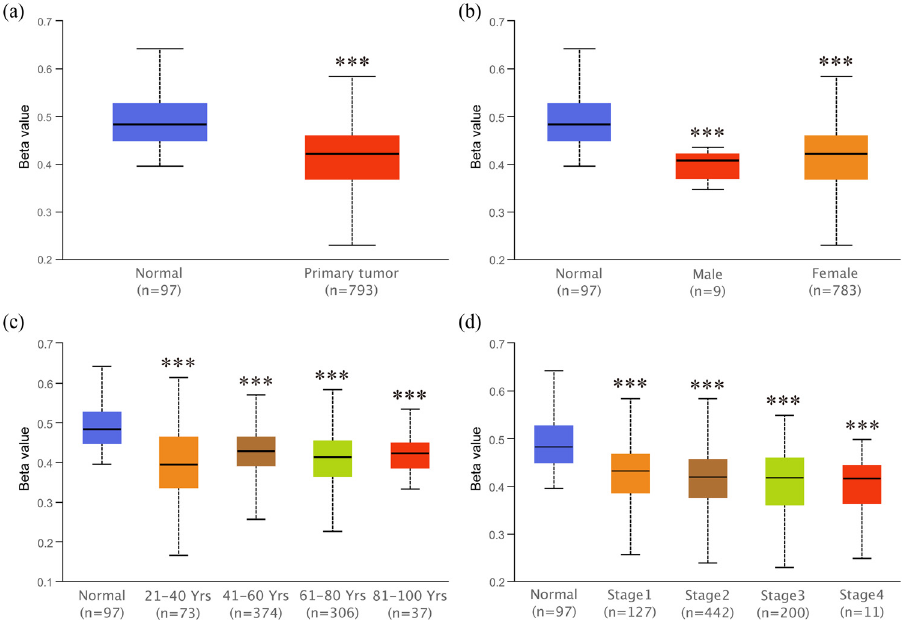
Figure 5: Analysis of ZG16B promoter methylation status in breast cancer patients with di ff erent clinical - pathologic features. Ualcan analysis showed the methylation level of ZG16B promoter in primary tumor of breast cancer ( a ) and in breast cancer patients with distinct gender ( b ) , age ( c ) , and cancer stages ( d ) . Asterisks were marked to show the signi fi cance of each group compared with normal group ( * p < 0.05, ** p < 0.01, *** p < 0.001 )